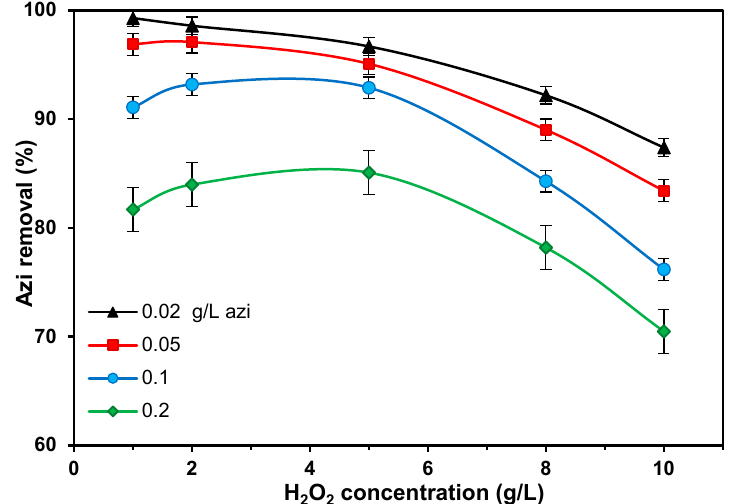
Figure 9. Effects of Azi and H 2 O 2 initial concentrations on the Azi removal; pH = 5, Mn-BTC arg /Al catalyst dosage of 6 g/L and after 40 min treatment.